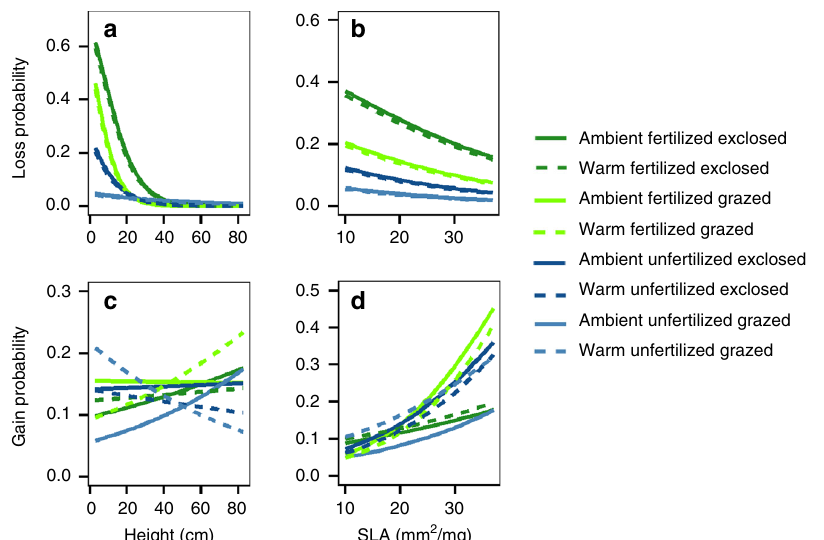
Fig. 4 Impacts of plant height and speci fi c leaf area on probability of species losses and gains. Modeled probability of species ’ losses and gains as functions of their height a , c and SLA b , d under combinations of warming, grazing and fertilization treatments. Fertilized plots are shown in green , unfertilized in blue . Herbivore exclosures are indicated with dark color , grazed plots in light color . Dashed line indicates prediction for warmed plots, solid line for unwarmed plots. Modeling results can be found in Supplementary Tables 3,